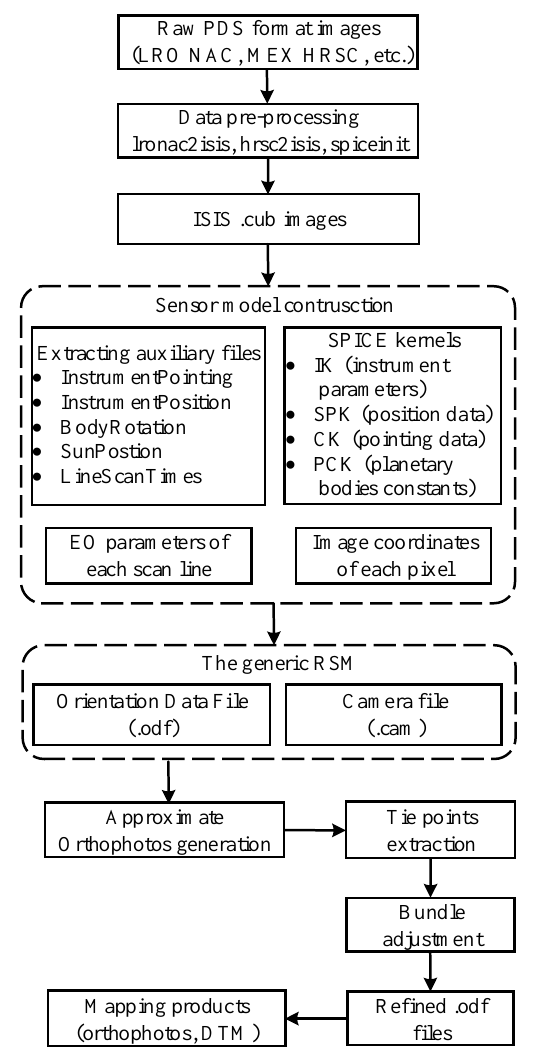
Figure 1. The construction of the developed generic rigorous sensor model (RSM) and the overall photogrammetric processing procedures based on approximate